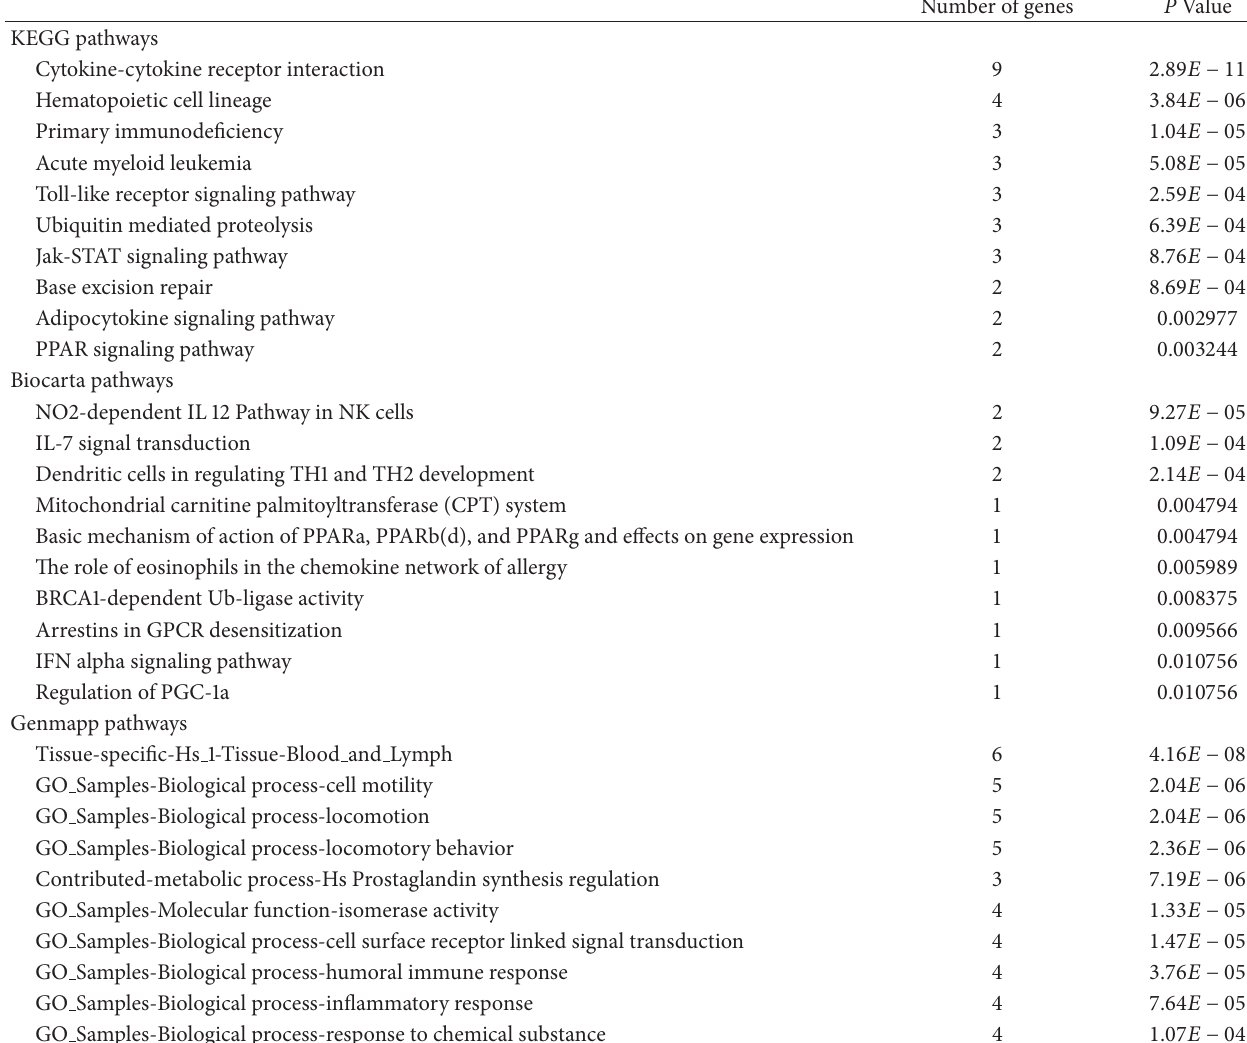
Table 5: Top ten enriched signaling pathways with significant association with estrogen-relevant DEGs (healthy